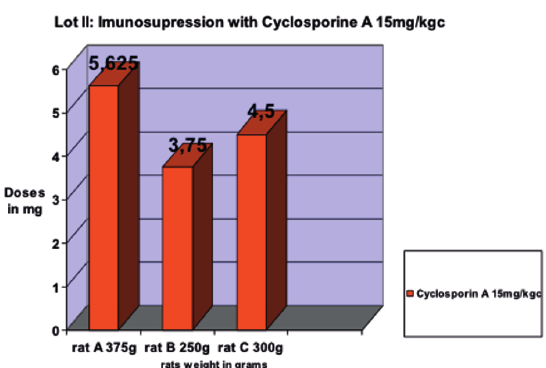
Table 3. The imunosuppresion regim in postoperation